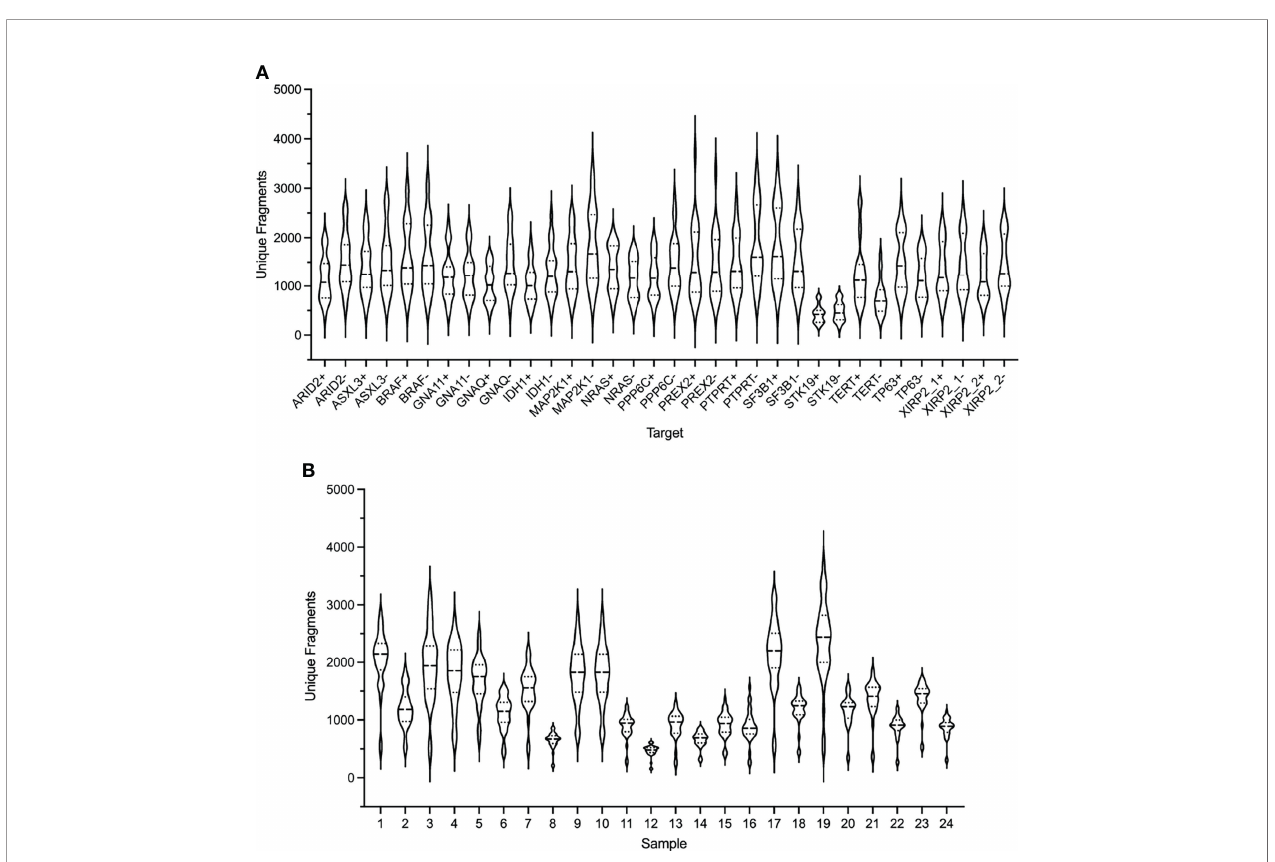
FIGURE 1 | Performance of the ArcherDX custom melanoma ctDNA panel. (A) Distribution of unique fragments for each gene speci fi c target in the custom melanoma panel based on sequencing of 24 samples. For each gene target (see Table S1 for targets) both + and – DNA strand generated fragments are shown. (B) Distribution of unique fragments obtained for each sample based on the 34 targets shown in (A) . Samples 1-21 are melanoma patients and 22-24 are healthy controls. Next generation sequencing (NGS) libraries were generated using an ArcherDX Liquidplex NGS work fl ow followed by Illumina MiSeq sequencing. Unique fragments were de fi ned as deduplicated consensus reads having the same unique molecular barcode. Violin plots show median and